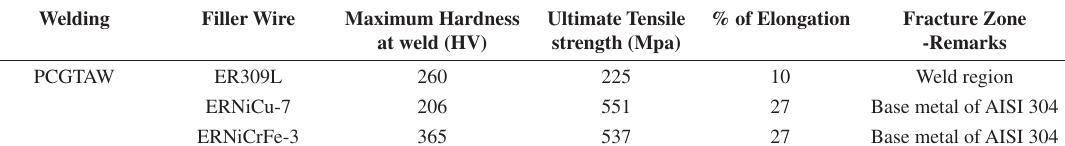
Table 3. Room temperature mechanical